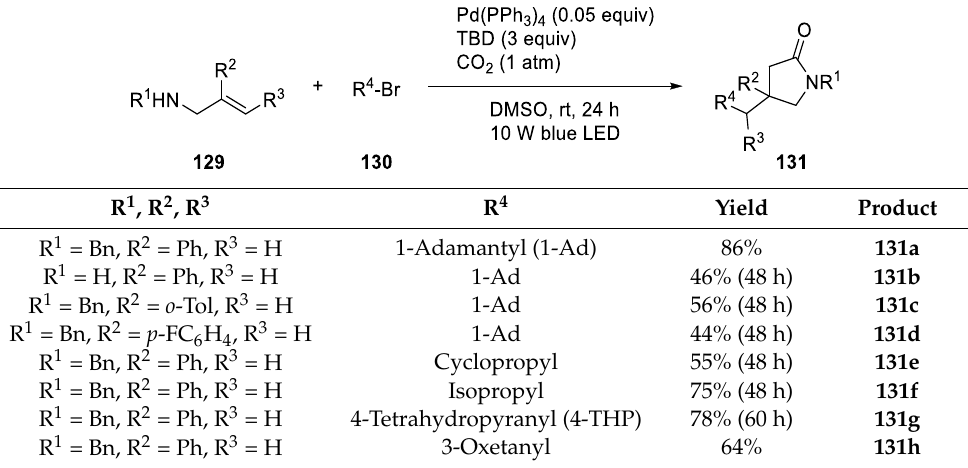
Table 1. Yu’s carboxylative cyclization/alkylation process [60]. The yields of some representative examples are given in the table.